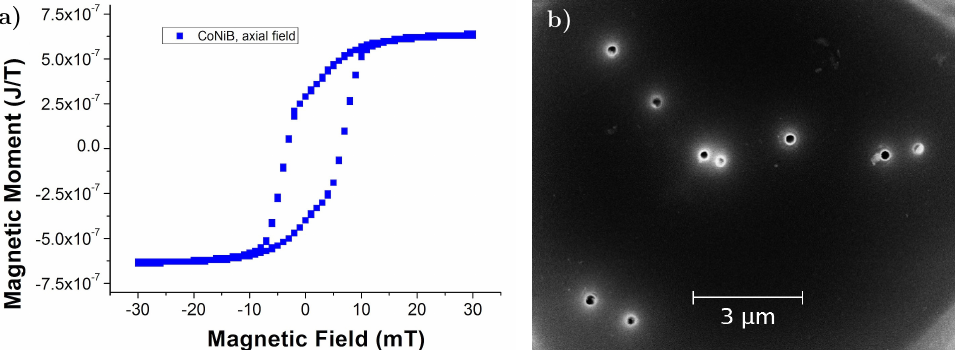
Fig. 8: Magnetometry on array of tubes. a) Hysteresis loop on a sparse array (low density, low interactions) of CoNiB tubes in the polycarbonate template, measured by VSM-SQUID. The field is applied parallel to tube axis. b) Scanning electron mi- croscopy, top view of a part of the measured template illustrating the low density of